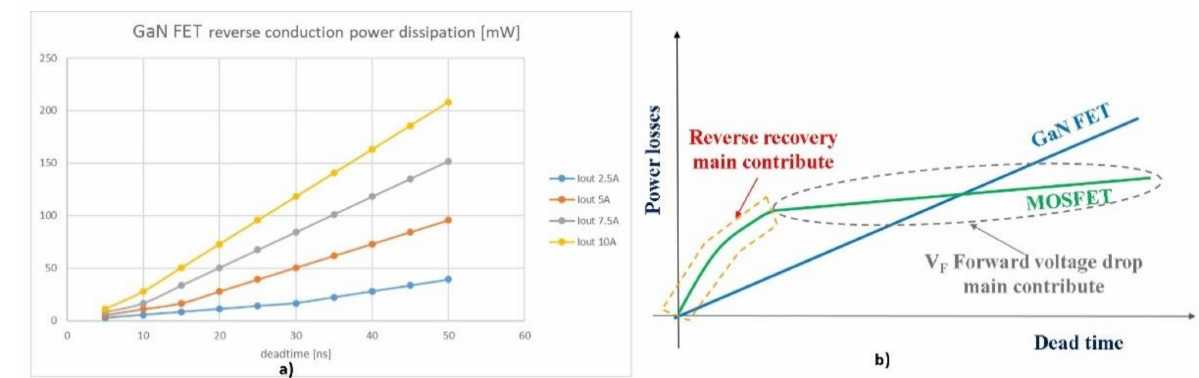
Figure 14. ( a ) Dead time power losses versus dead time variation at different output current (EPC2206 GaN FET). ( b ) Qualitative curves for comparison of dead time losses for MOSFETs and GaN